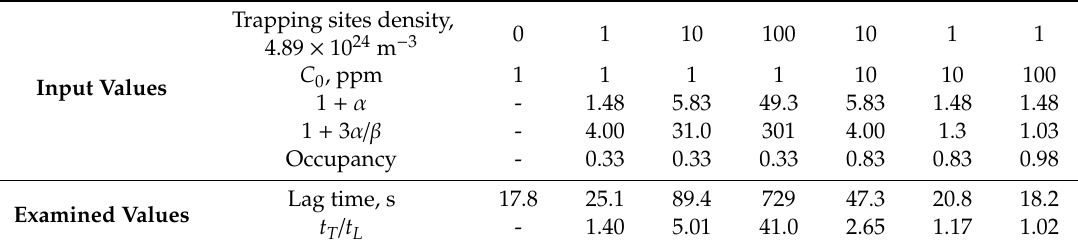
Table 2. Input and examined parameters of simulated permeation curves considering reversible trapping